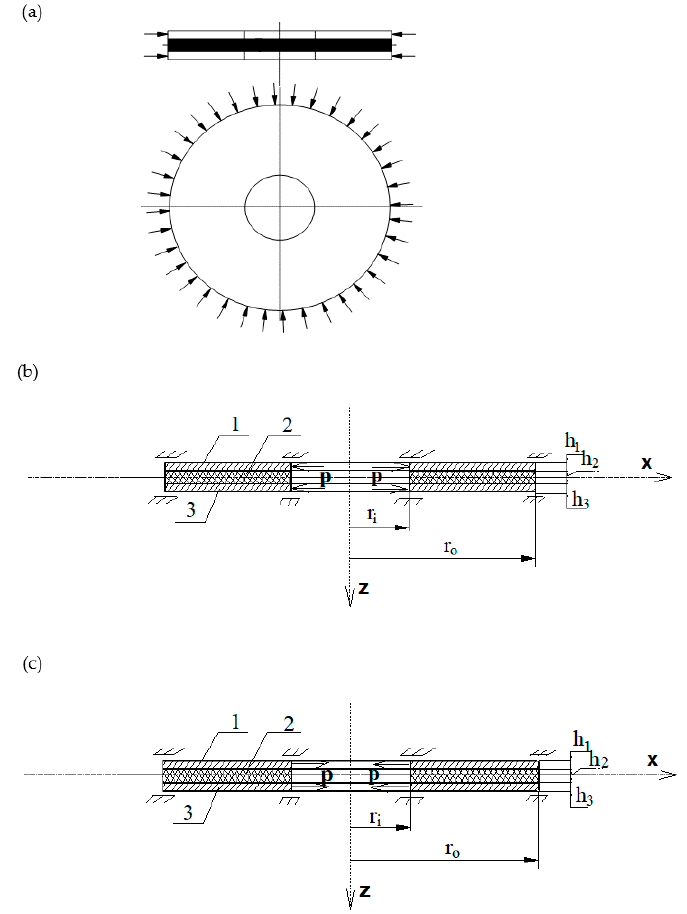
Figure 1. The scheme of the plate radially compressed on the outer edge ( a ). Cross-sections of the plates (1,3—outer layers, 2—core) when radially compressed on the inner edge ( b ), and radially stretched on the inner edge ( c ).